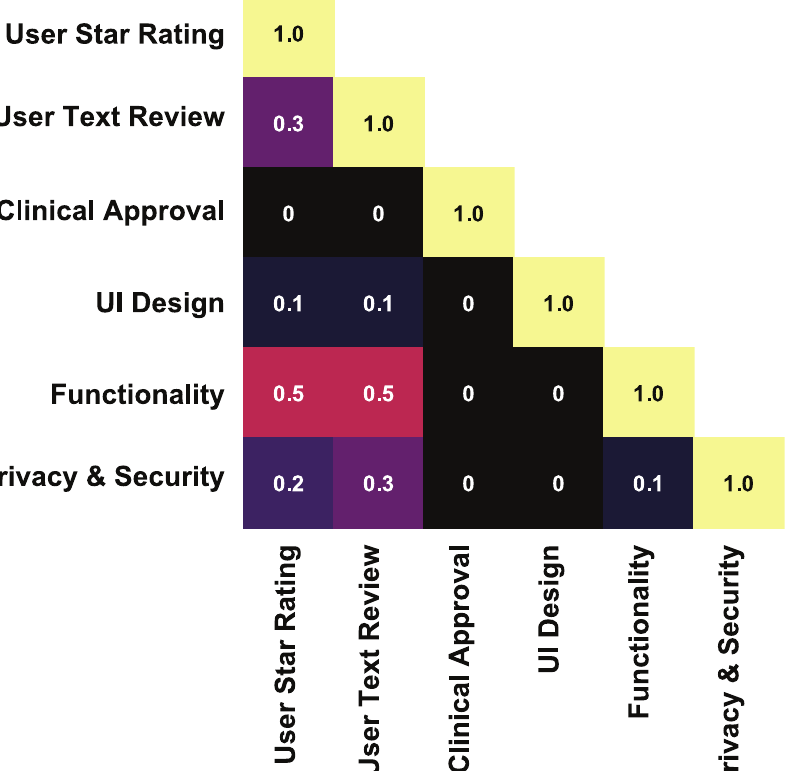
Fig 10. Correlation matrix illustrating the coefficient among factors considered for the assessment of the app